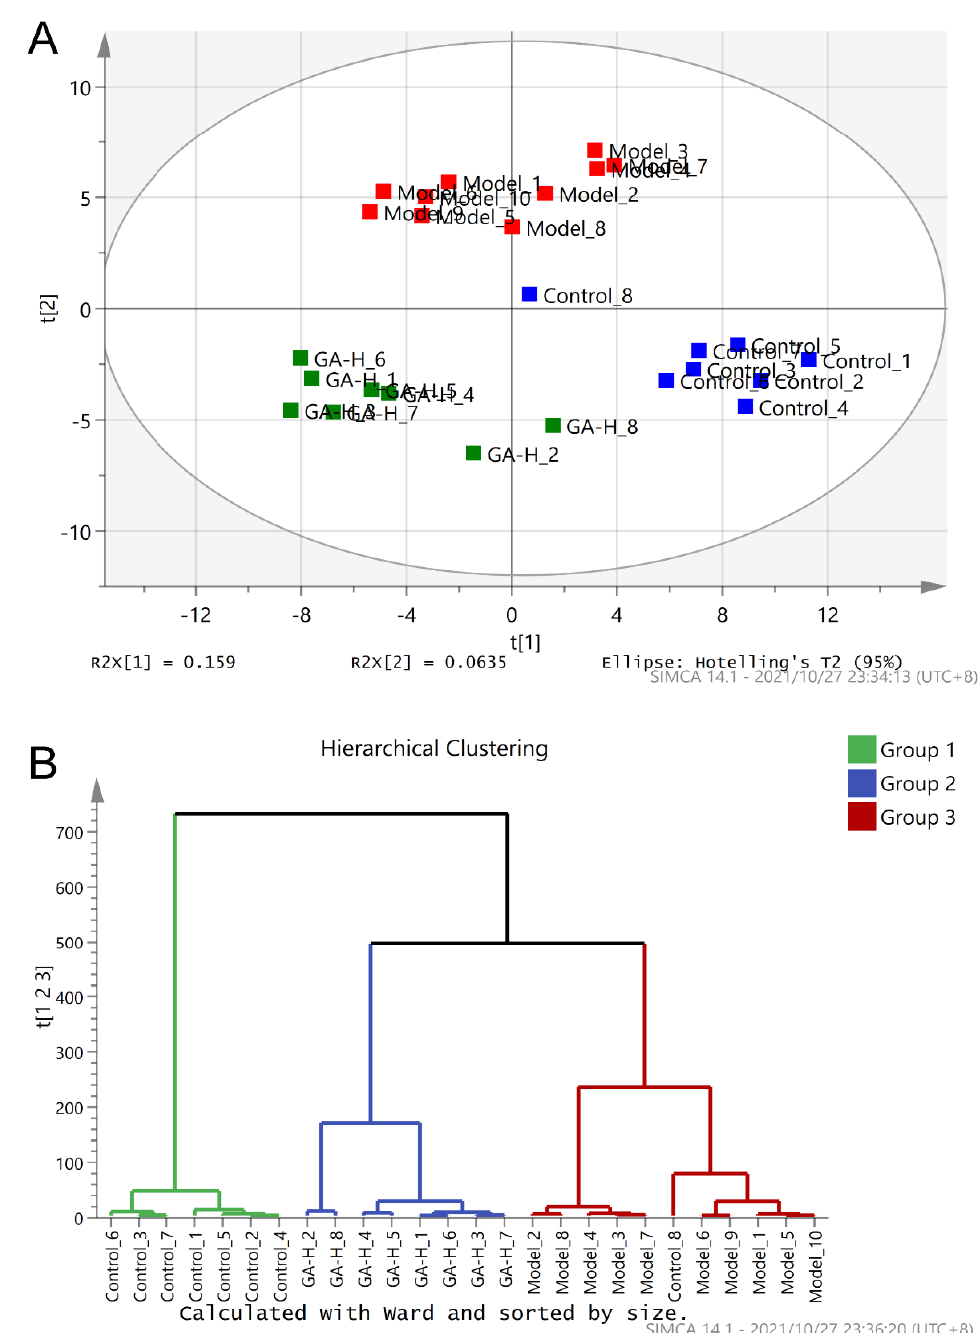
Figure 4. Regulation of GA intervention on the intestinal microflora in mice with excessive alcohol consumption for six weeks. ( A ) Principal component analysis (PCA) score plot; ( B ) hierarchical clustering analysis of intestinal microflora of different experimental groups.